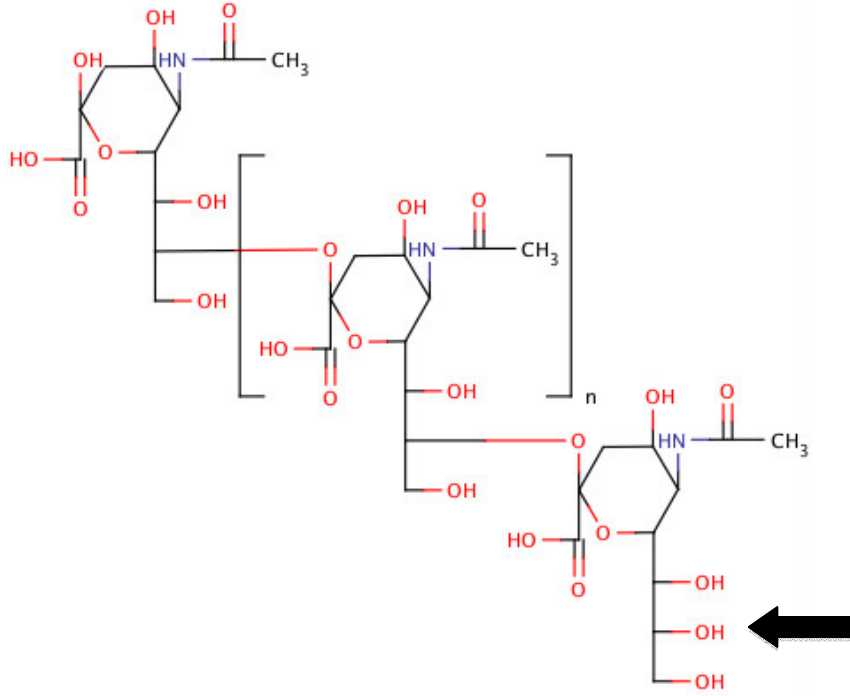
Figure 2. The structure of polysialic acid: the arrow indicates the site where an aldehyde group is introduced by periodate